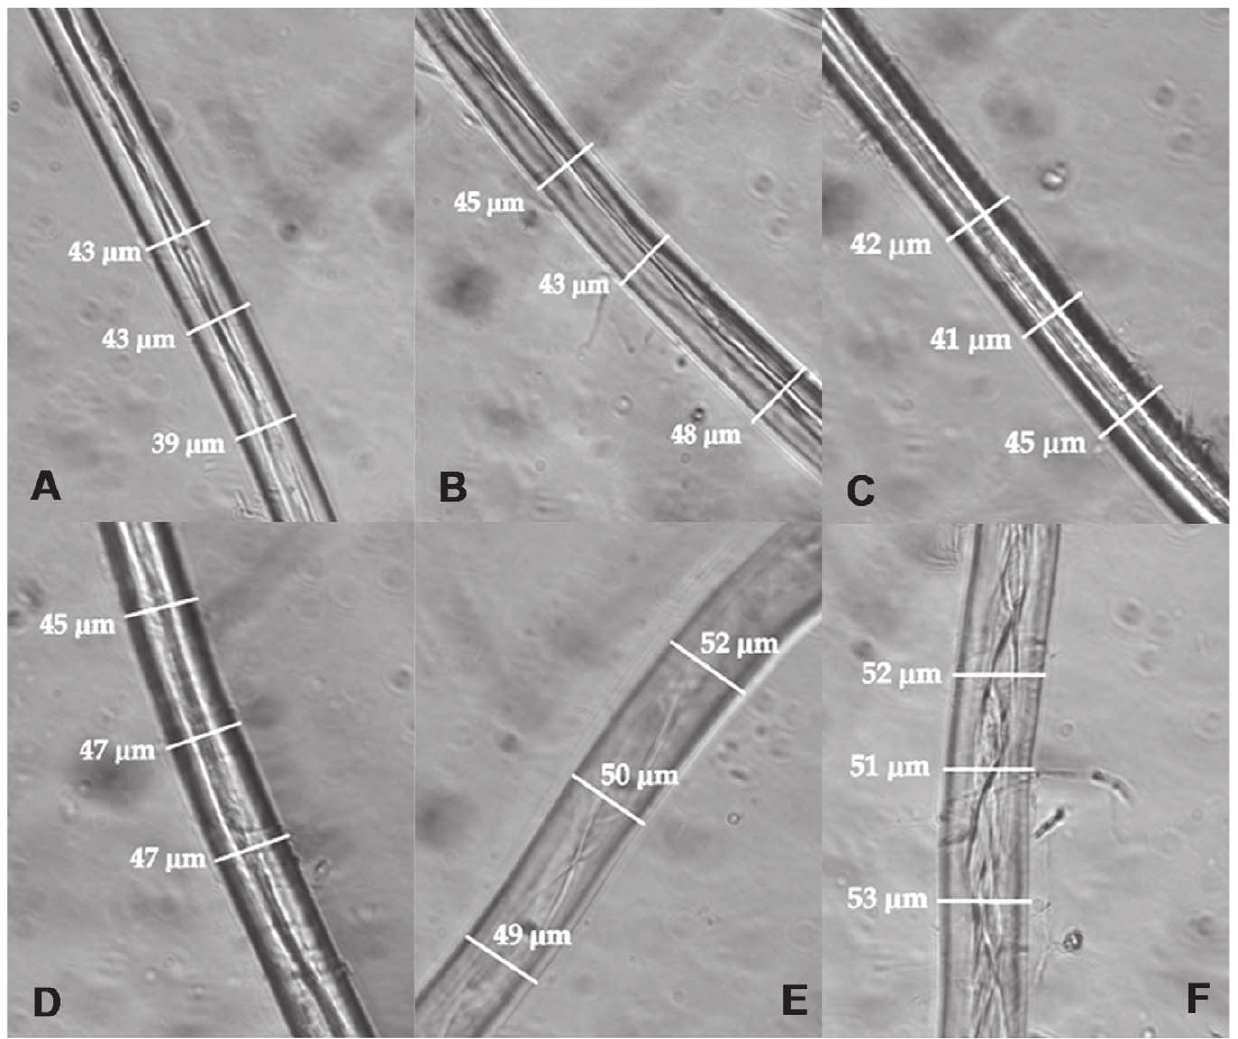
Figure 5. Phase contrast microscopic evaluation of cotton fiber treated with swollenin and cutinase. Average width of cotton fiber is given in brackets. A, Untransformed E. coli extract (41.6 m m). B, Purified cutinase (45.3 m m). C, Chloroplast cutinase (42.6 m m). D, Untransformed extract (46.3 m m). E, E. coli Swo1 (50.3 m m). F, Chloroplast Swo1 (52.0 m m).